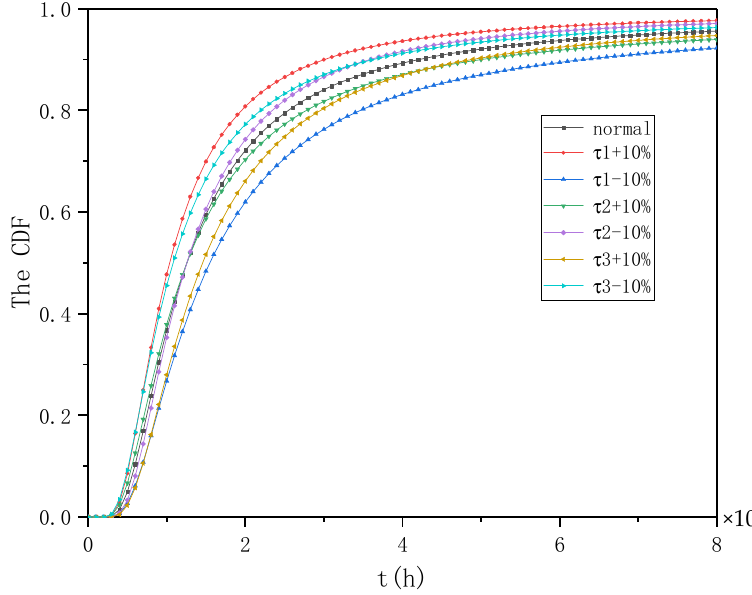
M with a fluctuation range of ±10%. Figure 4. Sensitivity analysis of M 0 with a fluctuation range of ± 0